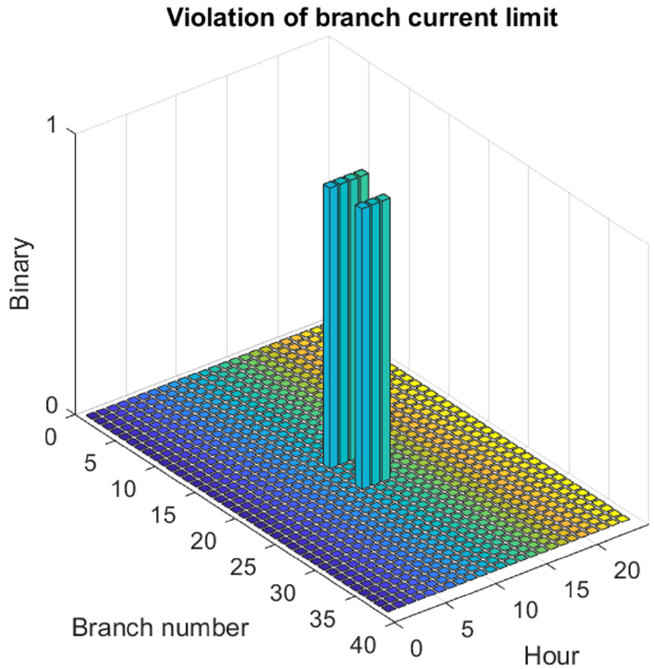
Figure 7. Violation of branch current limit using the PF calculation before using optimal energy management with the VPP concept.